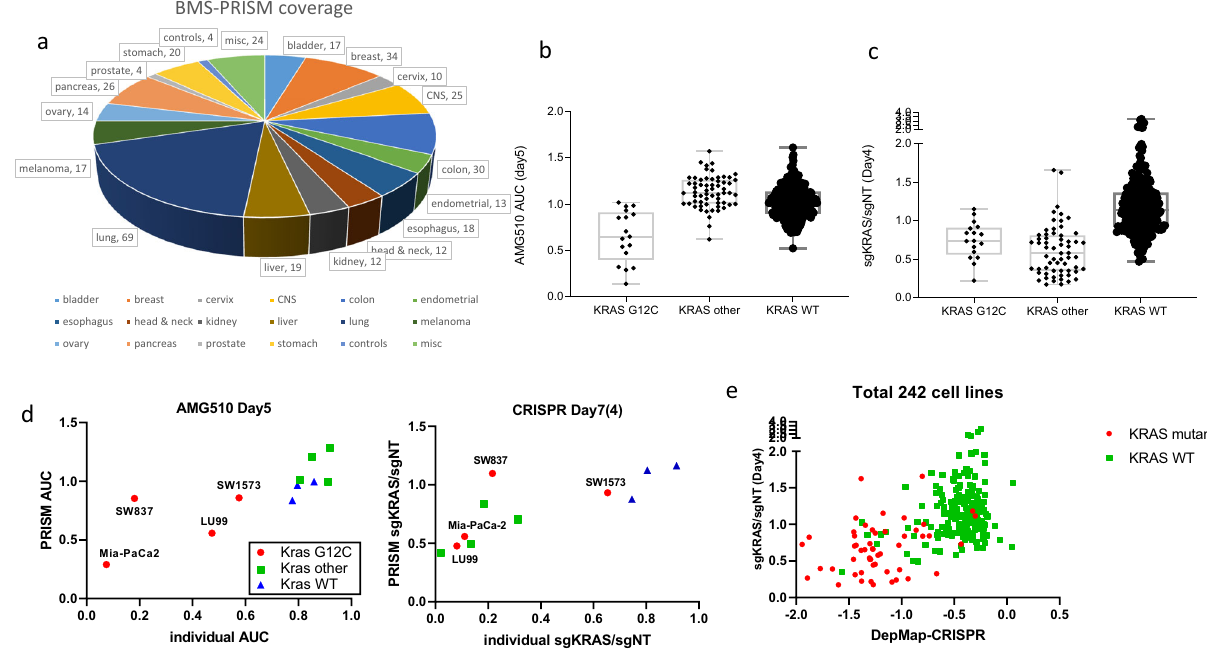
Fig. 3 KRAS-dependency evaluation in full-library PRISM analysis. a Pie chart showed the coverage of BMS-PRISM library composition. Total 368 cell lines were included in the current study. b Cell line response to Kras G12C inhibitor AMG-510 in PRISM screen. Cell lines were divided into three groups: KRAS G12C mutant (17 lines), KRAS other mutant (non-G12C, 61 lines), and KRAS wild-type (290 lines). c Cell line response to KRAS CRISPR knockout in PRISM screen (plotted with average of two sgRNAs). Cell lines were divided into three groups: KRAS G12C mutant (17 lines), KRAS other mutant (non- G12C, 61 lines), and KRAS wild-type (290 lines). Error bars represent standard error of the mean. d Validation of cell line response to KRAS perturbation in individual and PRISM assays (left, AMG-510 treatment; right, KRAS CRISPR knockout). KRAS G12C mutant (red circles); KRAS non-G12C mutant (green squares); KRAS wild-type (blue triangles). e Correlation analysis of KRAS CRISPR PRISM assay vs DepMap CRISPR gene effect score (CERES, 242 cell lines). KRAS mutant (red circles); KRAS wild-type (green